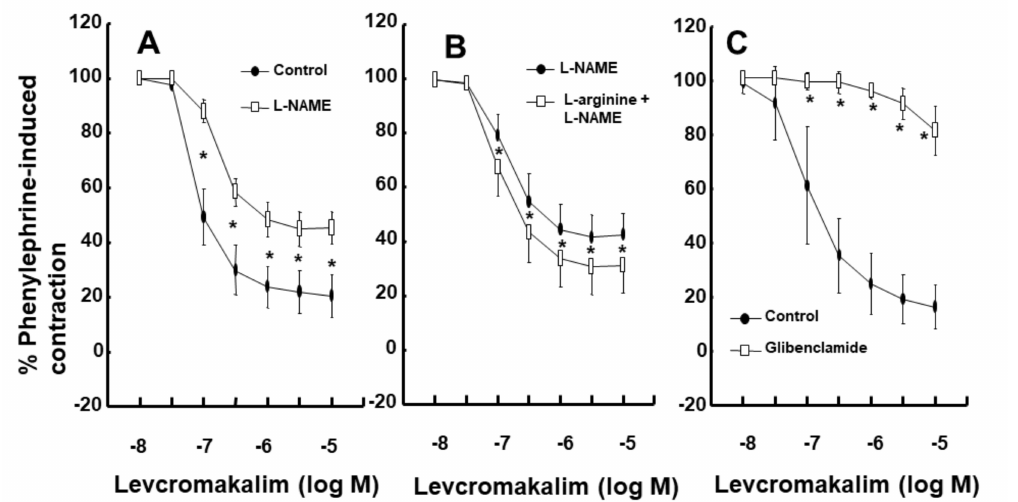
Figure4. E ff ectofN W -nitro-L-argininemethylester(L-NAME,10 − 4 M, n = 8)onlevcromakalim-induced vasodilation in isolated endothelium-intact rat aortae ( A ). E ff ect of L-arginine (10 − 4 M, n = 15) alone and e ff ect of combined treatment (M = 15) with L-arginine and L-NAME on the levcromakalim-induced vasodilation of endothelium-intact rat aortae ( B ). E ff ect of glibenclamide (10 − 5 M, n = 8) on the levcromakalim-induced vasodilation of endothelium-intact rat aortae ( C ). Data are shown as the mean ± SD and expressed as the percentage of the maximal contraction induced by phenylephrine (10 − 6 M). n indicates the number of isolated rat aortae. A: * p < 0.001 versus control. B: * p < 0.001 versus L-NAME alone. C: * p < 0.001 versus control.